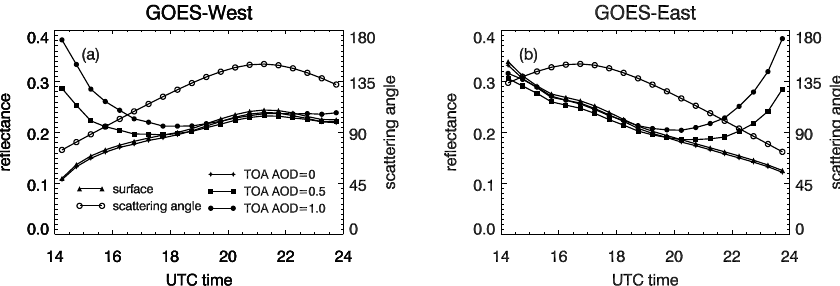
Fig. 2. TOA reflectance, surface reflectance and scattering angle vs UTC time calculated in the (a) GOES-West and (b) GOES-East geometry for Railroad Valley on a selected day (19 June 2008). The radiative transfer model, aerosol model and gases absorption parameters used are the same as those for the look-up table in Sect. 3.